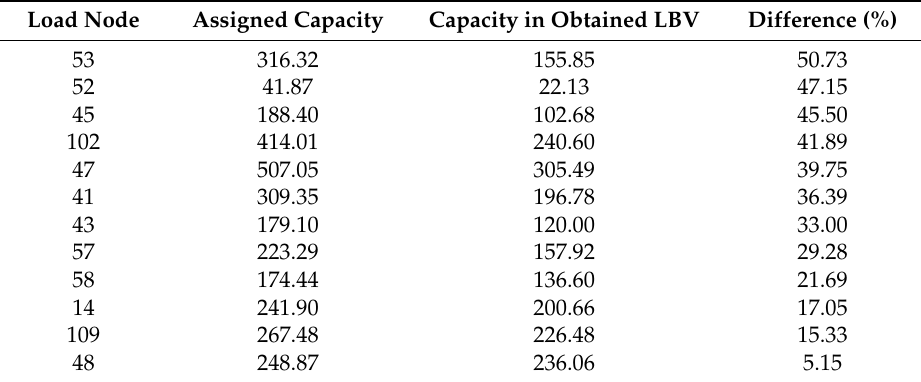
Table 5. Results of load node